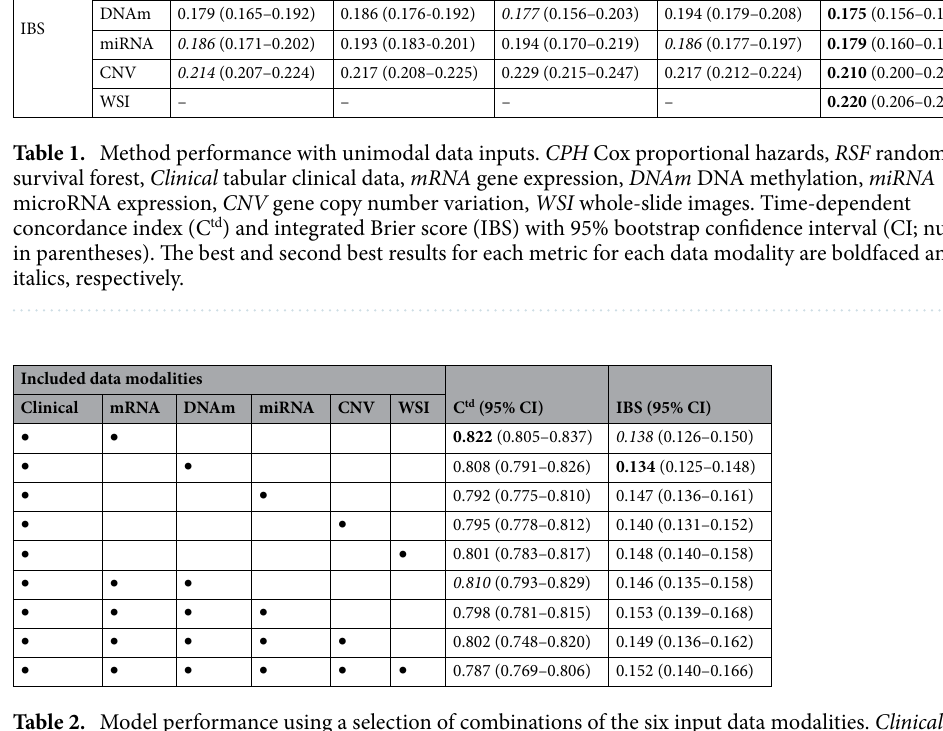
Table 2. Model performance using a selection of combinations of the six input data modalities. Clinical tabular clinical data, mRNA gene expression, DNAm DNA methylation, miRNA microRNA expression, CNV gene copy number variation, WSI whole-slide images. Individual data modalities included in each evaluated model are marked with • . The best and second best results for each metric are boldfaced and italics,